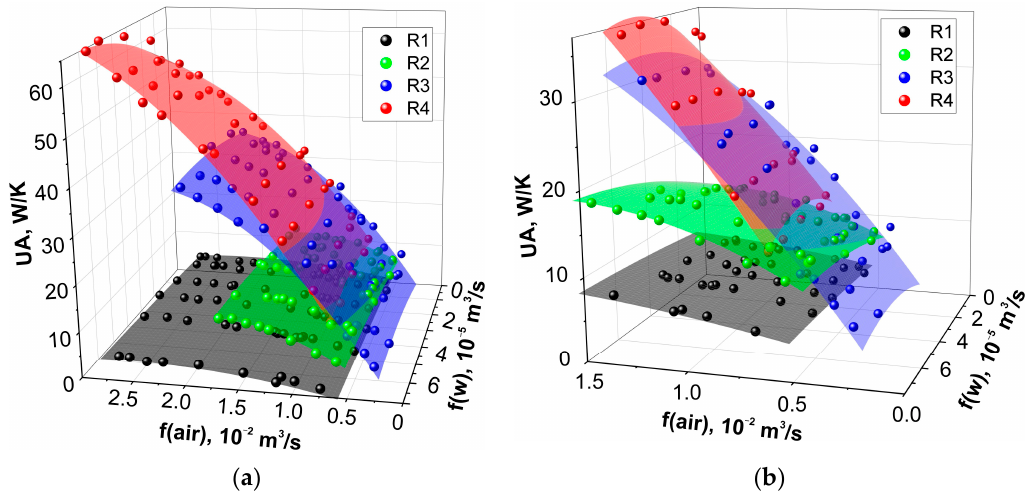
Figure 5. Experimentally measured global heat transfer coefficients UA for radiators R1–R4 at various rates of air and water flow. Planes—polynomial fitting. ( a ) Whole range of air flow, ( b ) low air flows.